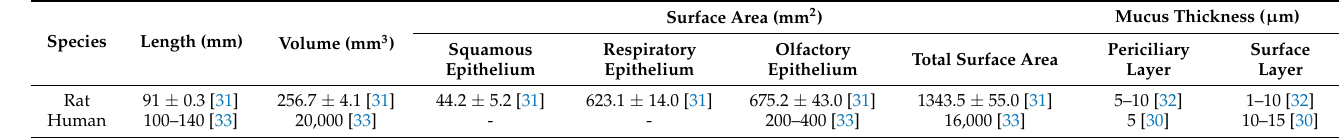
Table 3. HPLC analytical conditions for each